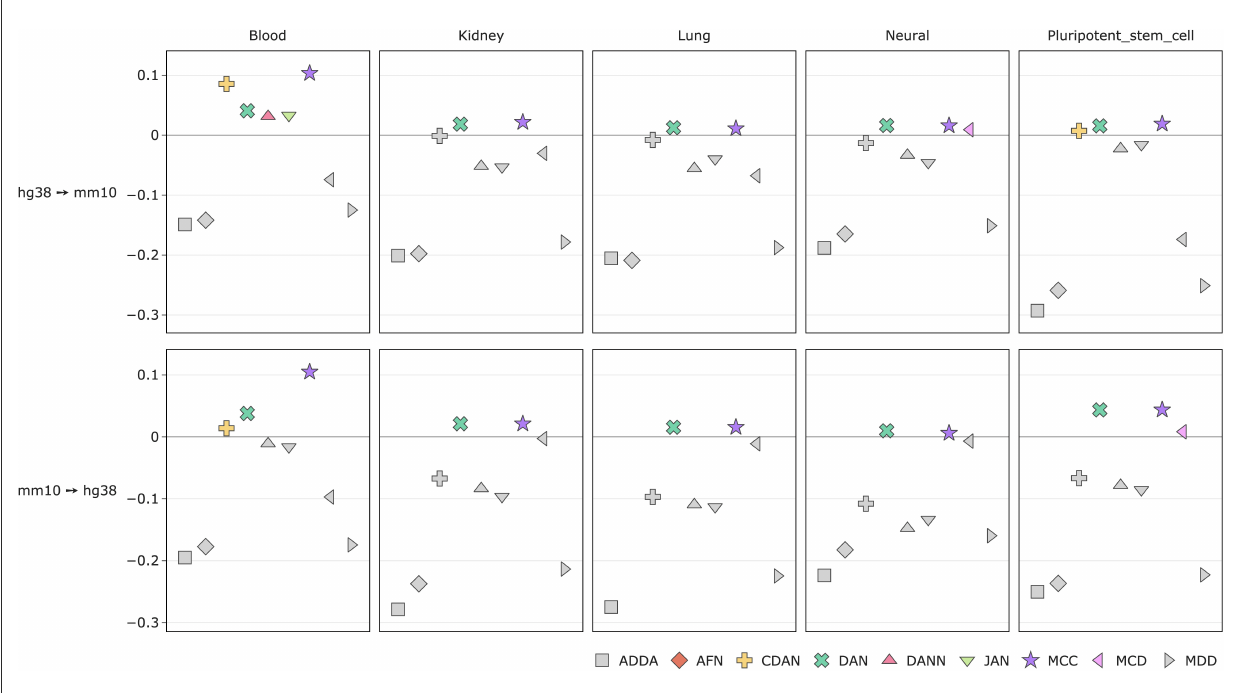
FIGURE7 Comparison of DA model performance (ROC AUC) across tissues for transcription factors (see comparison based on PR AUC and accuracy in Supplementary Figure